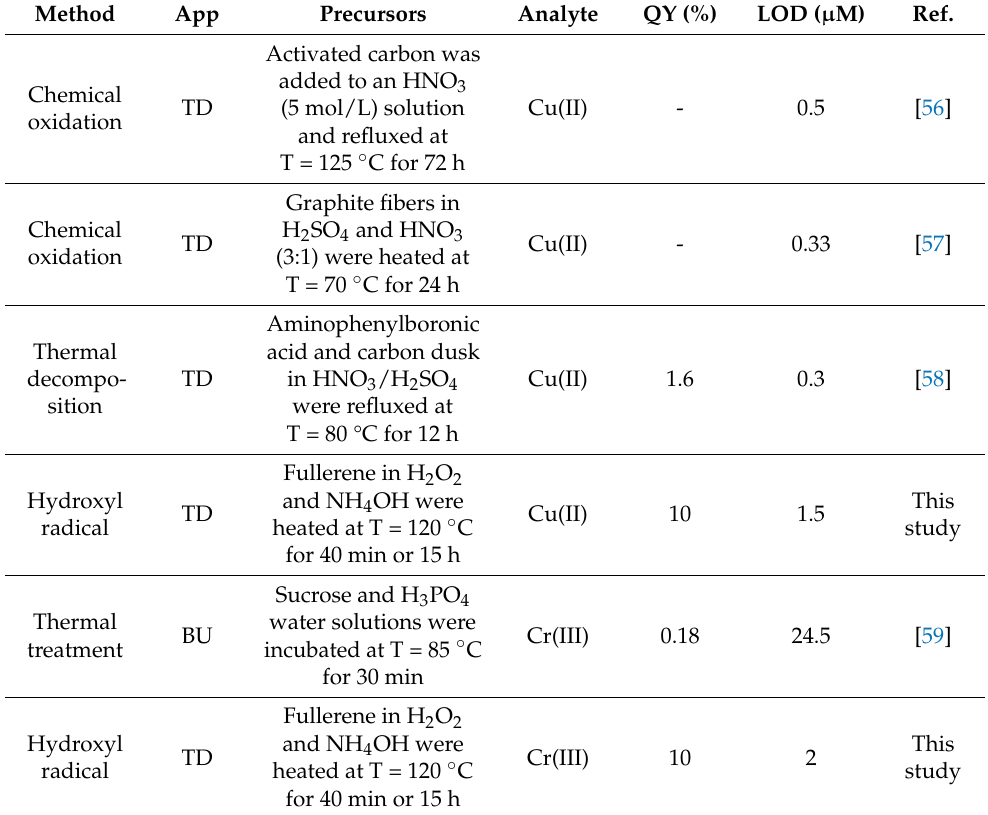
Table 2. Comparison between N-CQDs-15 h and literature data of top-down synthesized CQDs for Cu 2+ detection. For Cr 3+ , literature data of a bottom-up synthesis was taken. App = approach, TD = top-down, BU = bottom-up, QY = quantum yield, LOD = limit of detection. Method